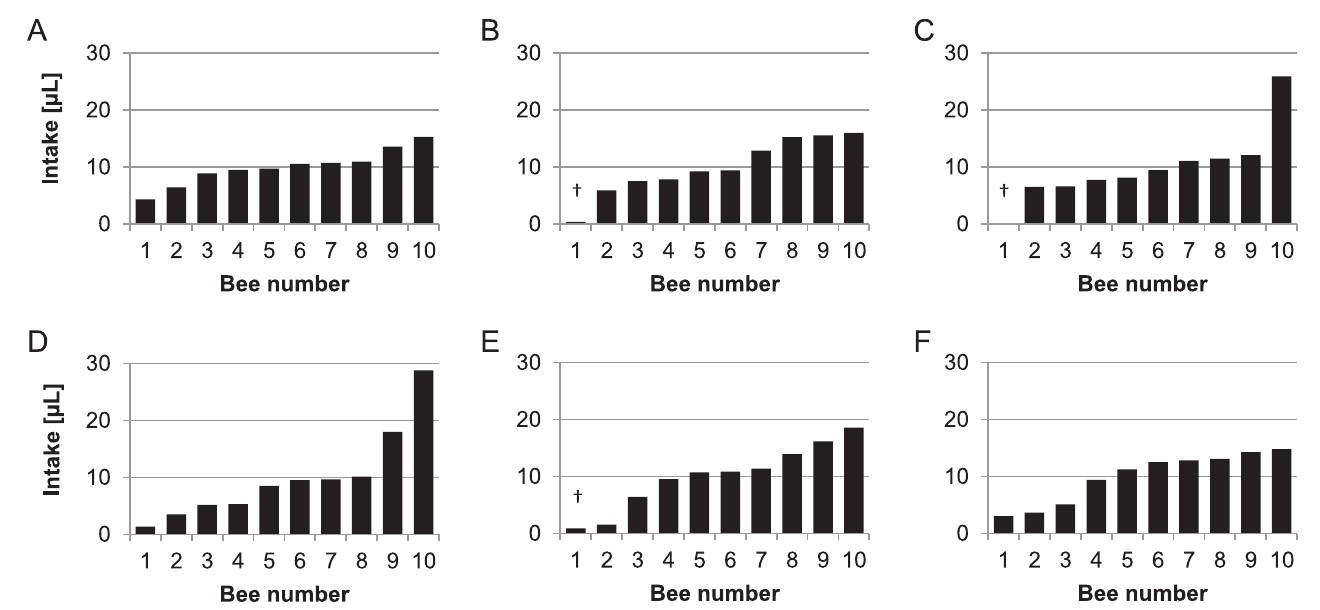
Fig 1. Individual intake per caged bee for six replicates (A-F) from experiment T1. Intake immediately after bees finished temporary feedingon 100 μ l of 14 C-labelled sugar diet. Full range intake ratio is the highestquantity of diet ingested by a bee dividedby the lowest quantity of diet ingested by a bee. Inner 80% intake ratio likewiseis second highestquantity ingesteddividedby second lowest quantity ingested.The inner 80% intake ratios in this experimentfor replicates A-F are: 2.1, 2.6, 1.9, 5.2, 10.3 and 3.9, respectively. † indicatesbees that died during the feedingphase.